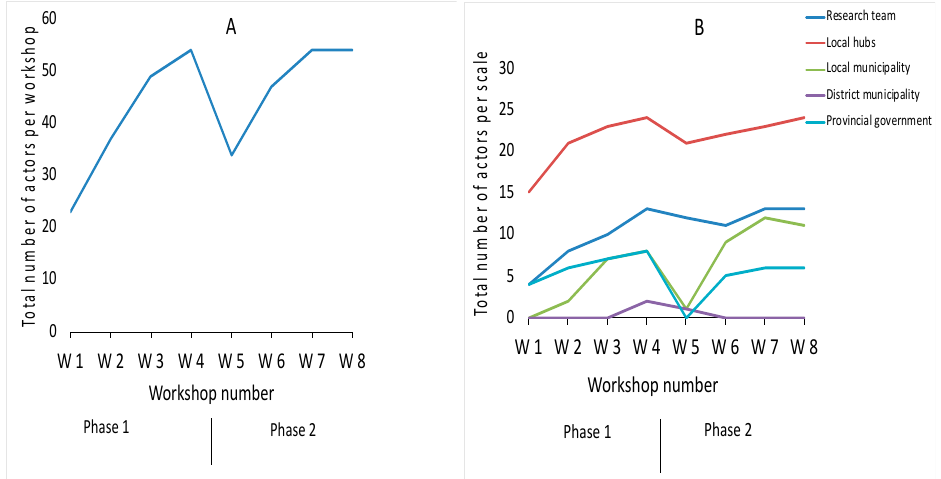
Figure 3. Trends and changes in the number of workshop attendees over time. ( A ) depicts changes in the total number of attendees and ( B ) depicts changes in the total number of attendees per scale. Figure 3 : Trends and changes in the number of workshop attendees over time. Figure 3A depicts W represents workshop changes in the total number of attendees and Figure 3B depicts changes in the total number of attendees per scale. W represents workshop number.